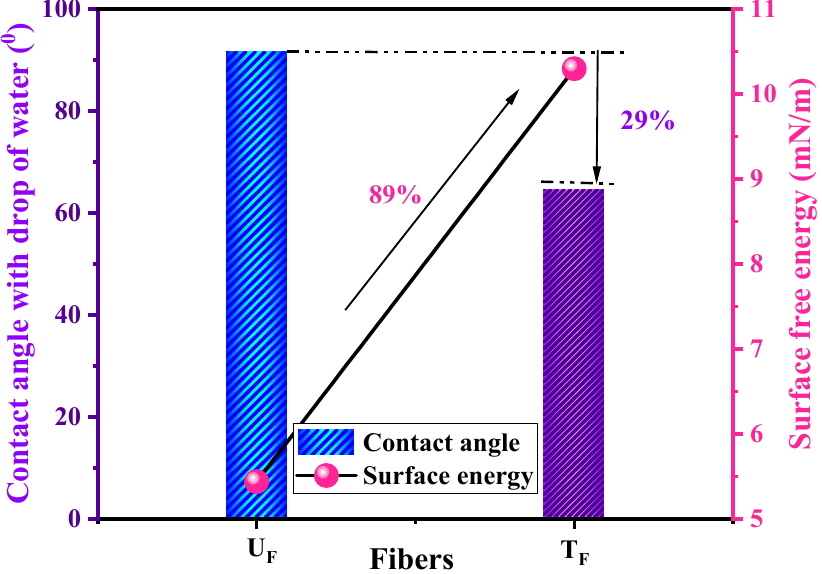
Figure 6. Contact angles and surface energies of untreated (U F ) and treated (T F ) fibers.